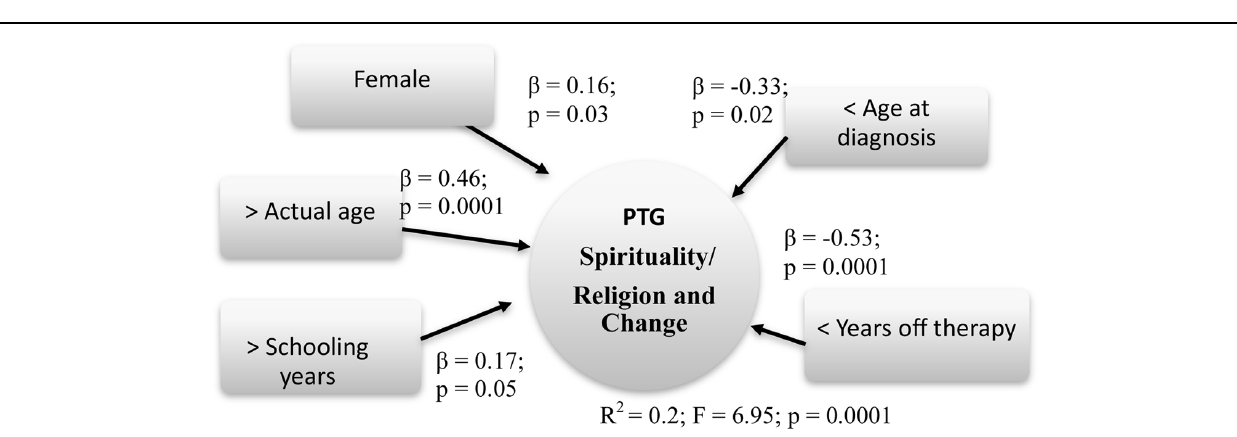
FIGURE 6 | Predictive factors of PTG spirituality/religion and change. Rectangle: stable Independent variables; Square: modifiable Independent variables; Circle: Dependent